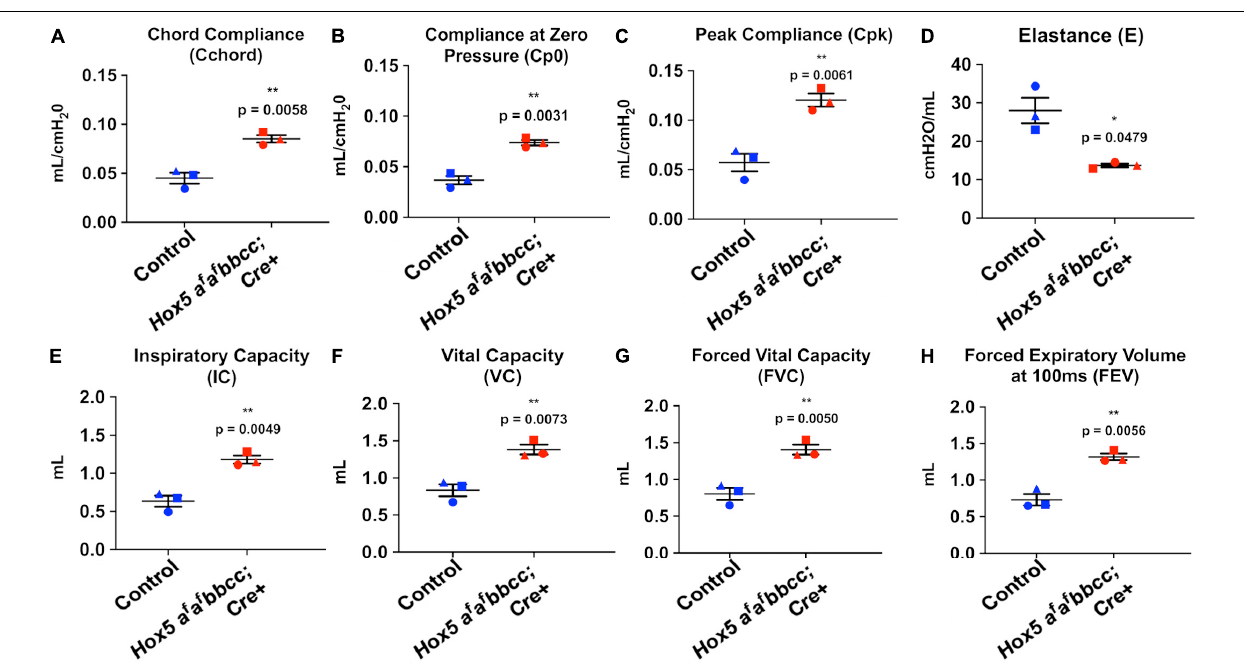
Frontiers in Cell and Developmental Biology | www.frontiersin.org